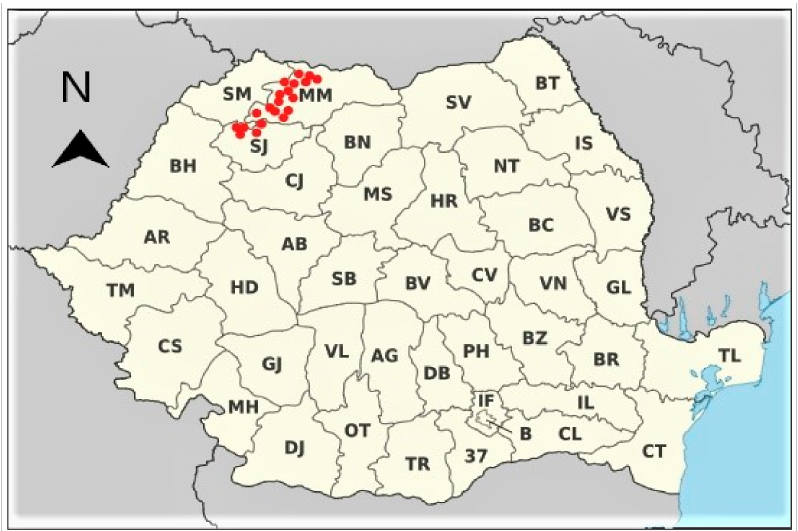
Figure 1. Map of the Mining and Smelting Complex Baia Mare (Northwest Romania) with the sampling